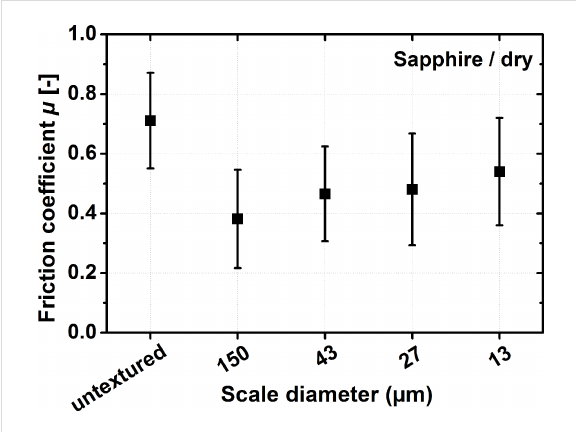
Figure 5: Comparison of the average friction coef fi cient for the last 250 m of unlubricated tribological experiments for a total sliding dis- tance of 1000 m. Results are presented for untextured polished controls and scale-like surface morphologies with scale diameters be- tween 13 and 150 µm. The experiments were conducted without lubri- cation and a steel-on-ceramic contact with sapphire as counter body material. The normal force was 2 N and the sliding speed 100 mm/s during all experiments. Please note that the abscissa is not to